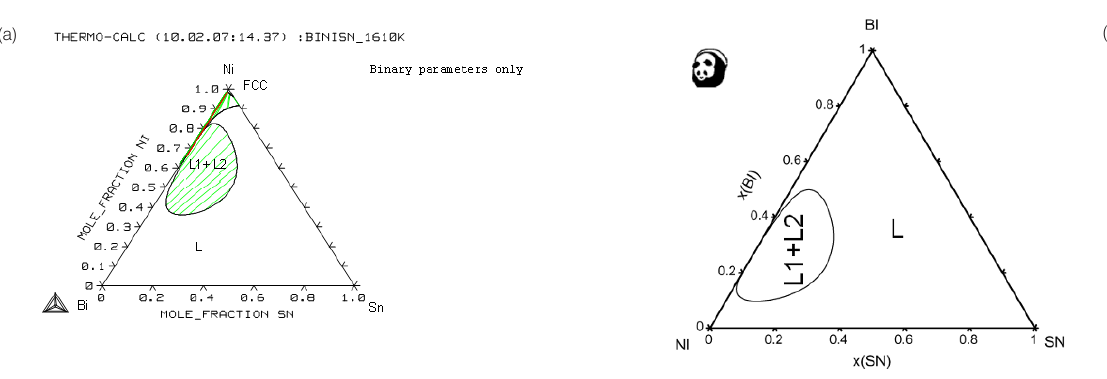
Figure 5. Isothermal sections of the system Bi-Ni-Sn, at 1610 K and at 1773, calculated in this work with optimized parameters of the binary systems [29] and [11], respectively. The phases are: FCC and liquid (L). Miscibility gap in the Ni-Bi-rich region of the system can